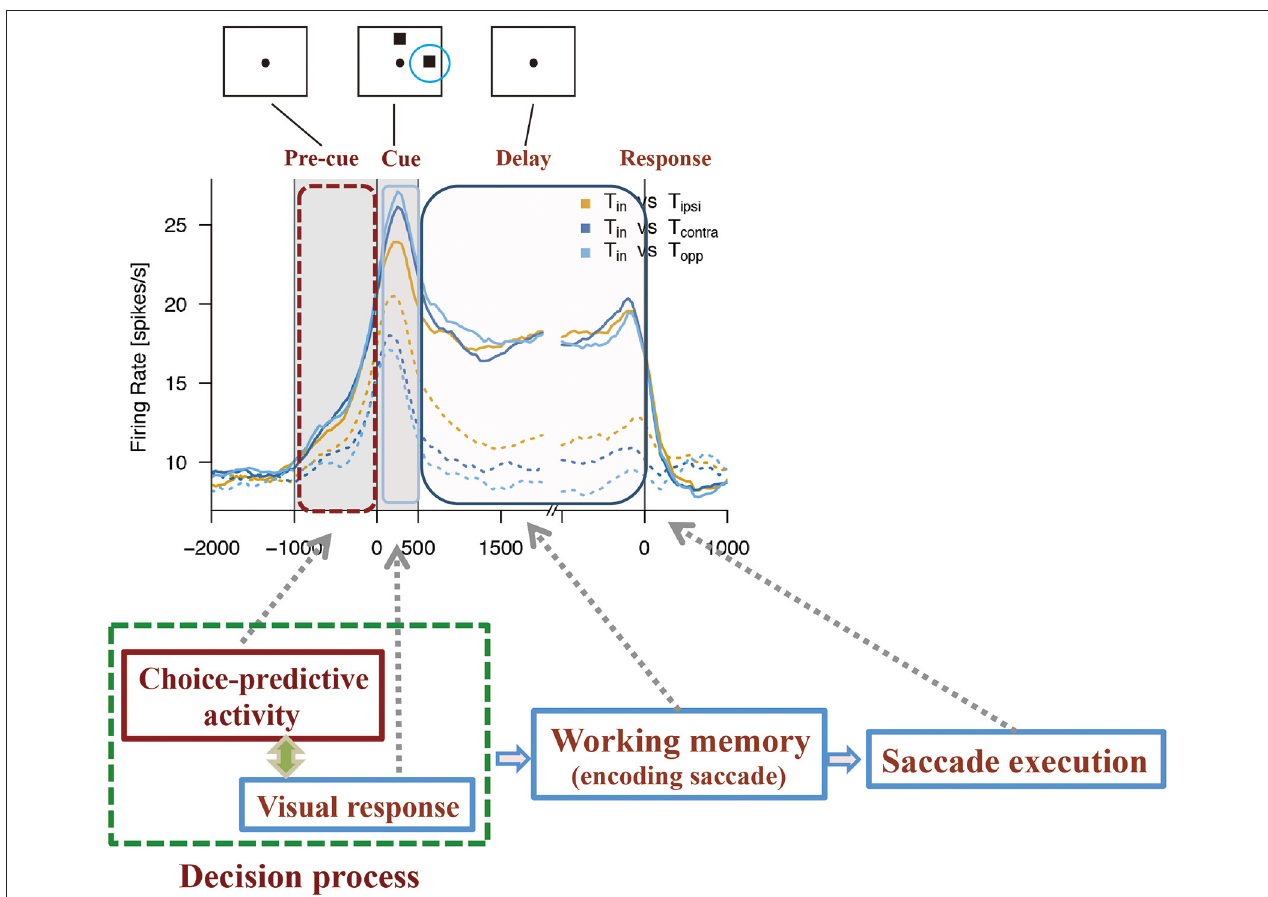
FIGURE 5 | Diagram to explain how choice-predictive activity could contribute to decision-making in free-choice conditions. Figures are reproduced from Mochizuki and Funahashi (2016) with permission from the copyright holder.